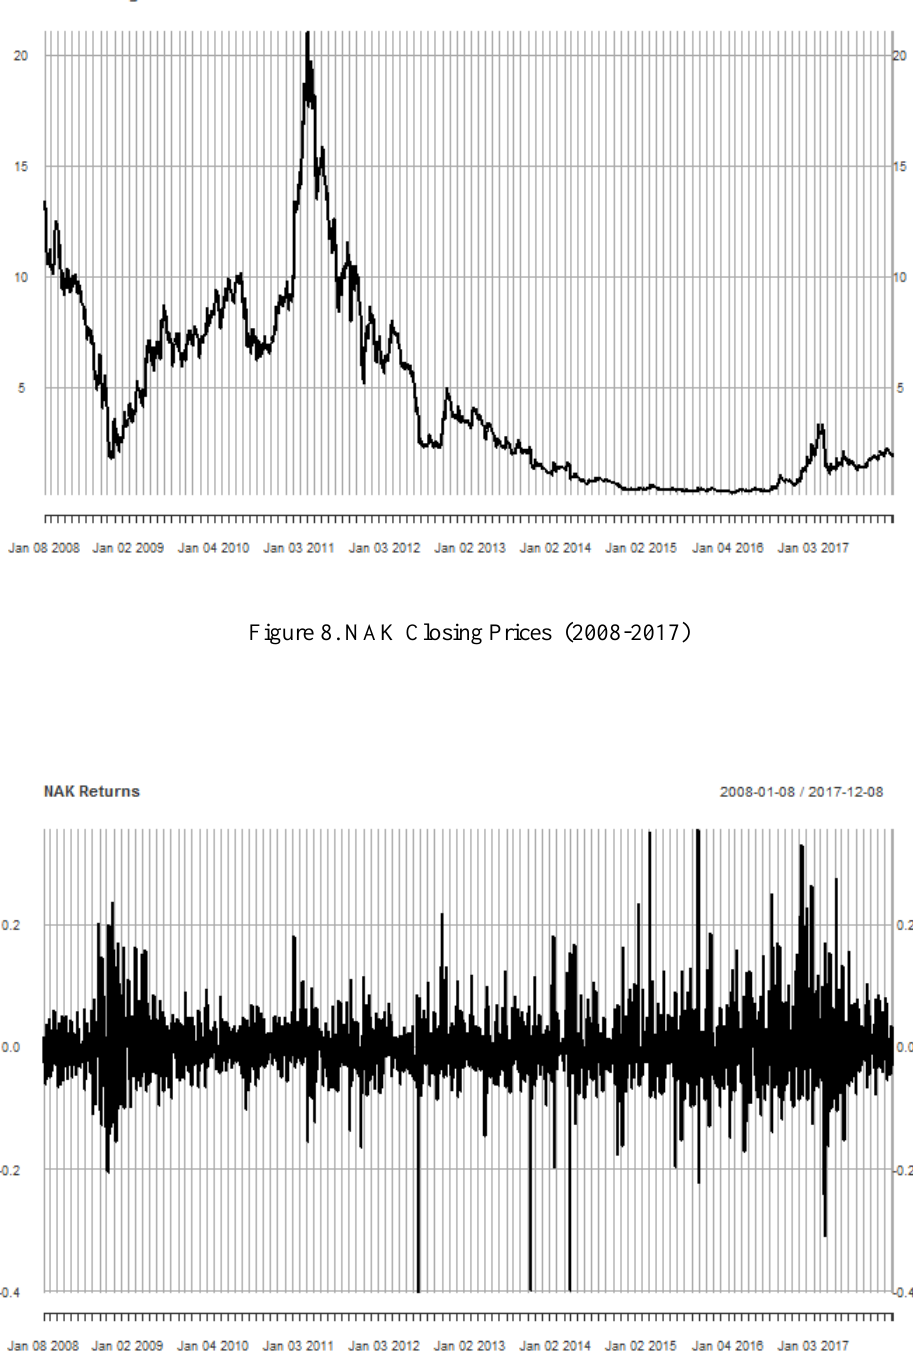
Figure 9. NAK returns